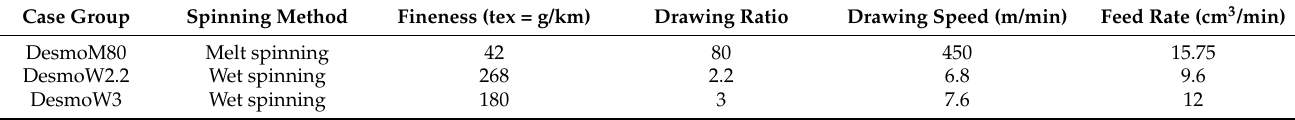
Table 1. Overview of spinning parameters and yarn characteristics of the three case